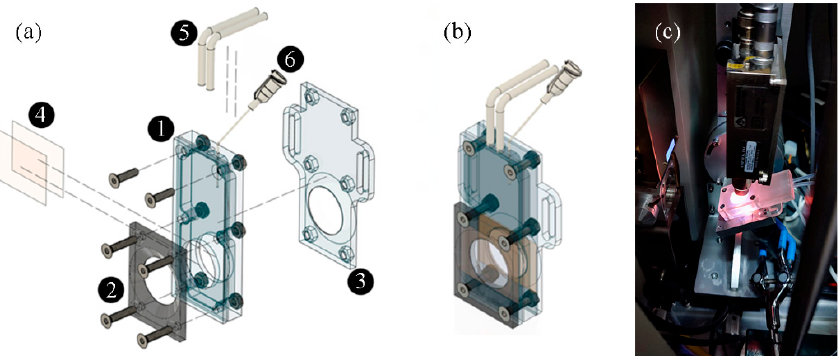
Figure 1. Schematic of the photocatalytic cell ( a ) and ( b ) with its main parts: 1—main body, 2—front window cap, 3—back window cap with fixture for Rigaku sample holder, 4—front and back windows, 5—pipes for gas inlet and outlet, 6—needle for liquid inlet/outlet. ( с ) Photo of the cell installed in the Rigaku R-XAS spectrometer during the photocatalytic experiment.